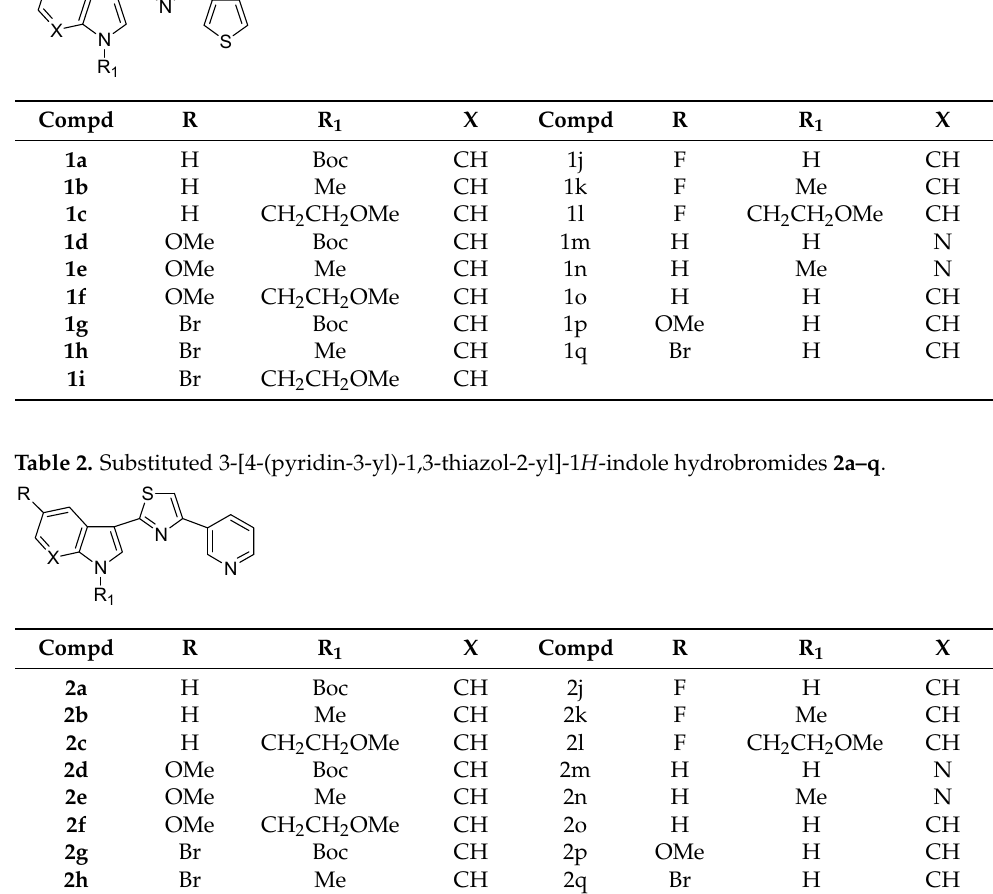
Scheme 1. Synthesis of new thiazole derivatives of type 1a–q and 2a–q . Reagents: (i) (a) Br 2 , DCM,